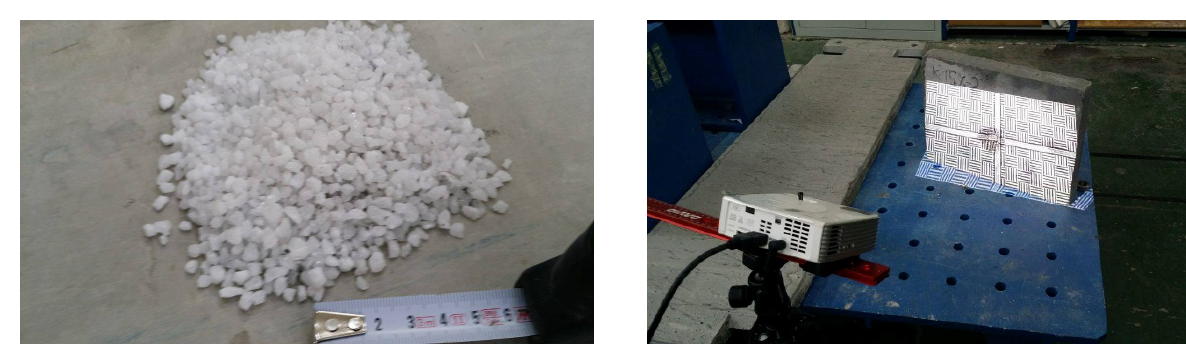
Figure 1. Corundum, fraction 3-5 mm. Figure 2. Capture the crater by using a 3D